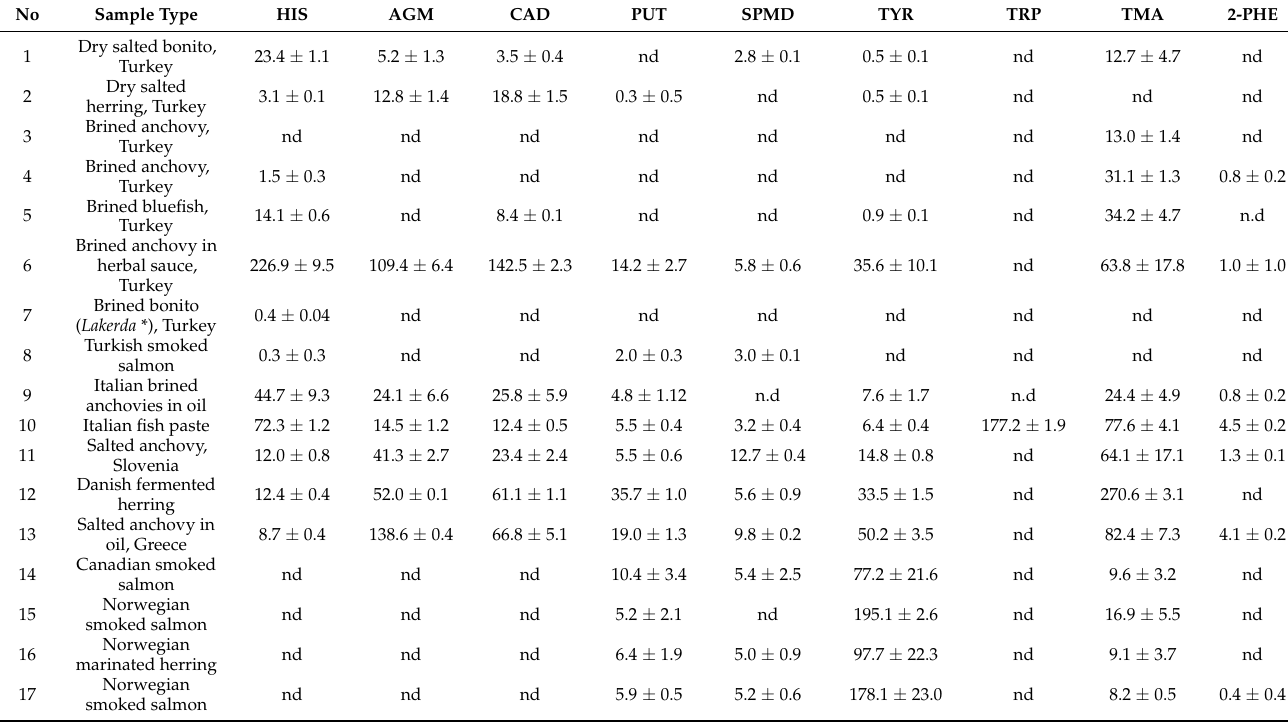
Table 3. The results of various traditional fish products for biogenic amine contents (ppm) analyzed by the newly developed IC-MS/MS